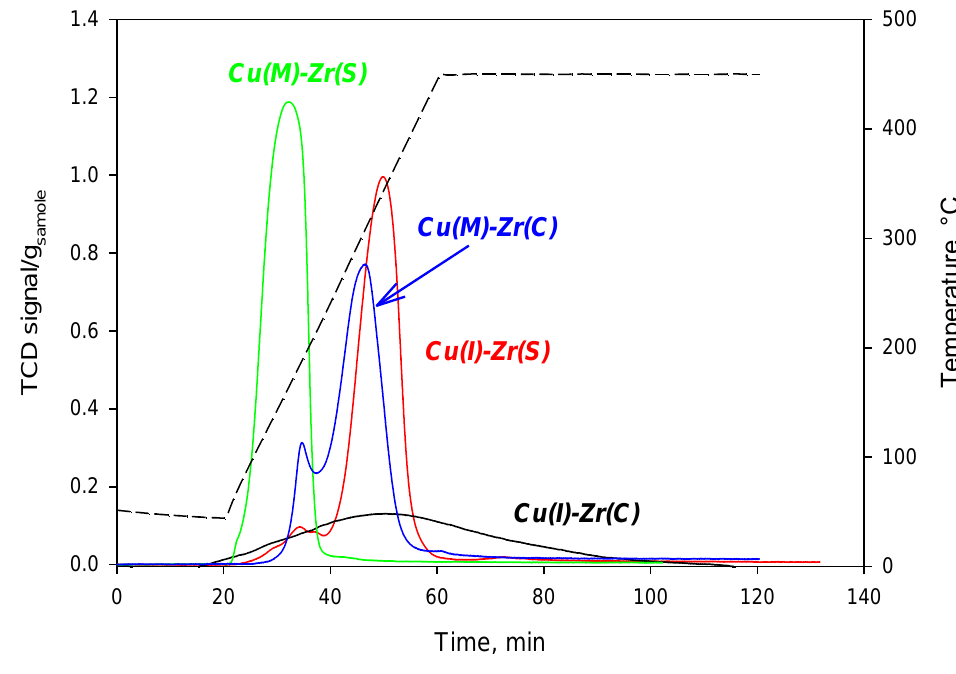
Figure 3. Profiles of H 2 -TPR tests over fresh samples.